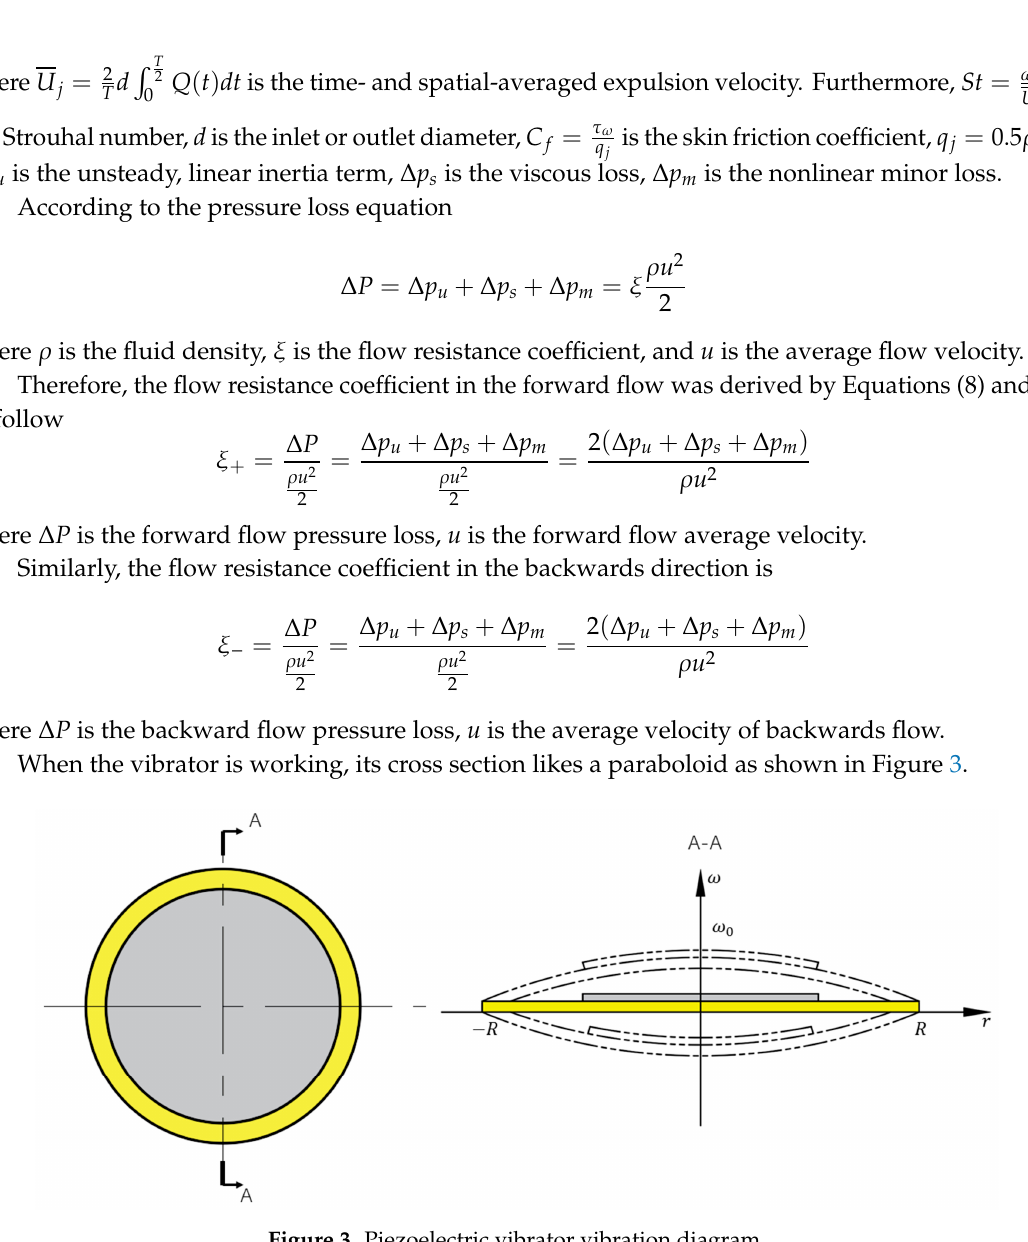
Figure 3. Piezoelectric vibrator vibration diagram.